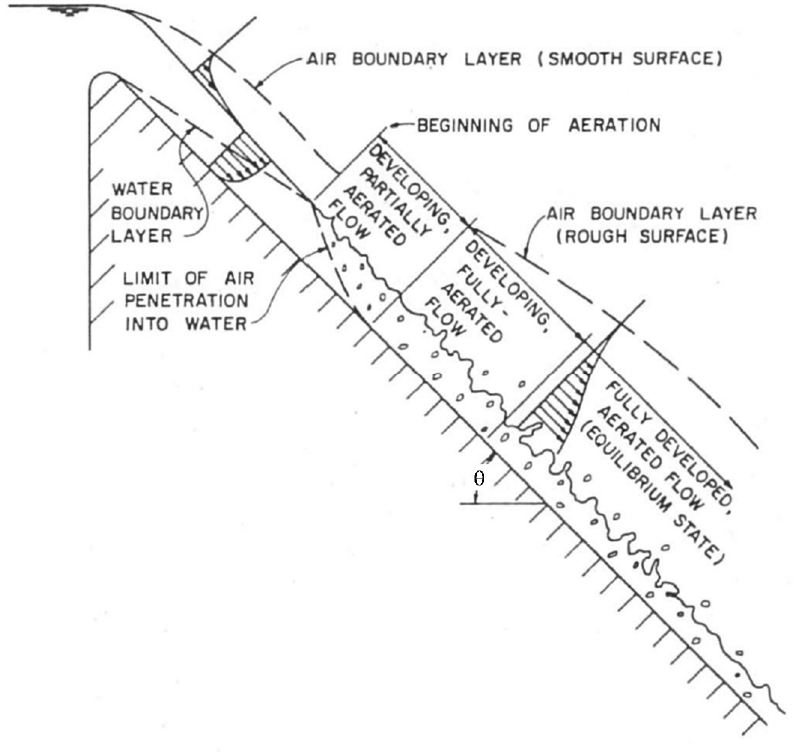
Figure 1. Development of air entrainment in open channel flow down a smooth, steep chute (adapted from [4]).